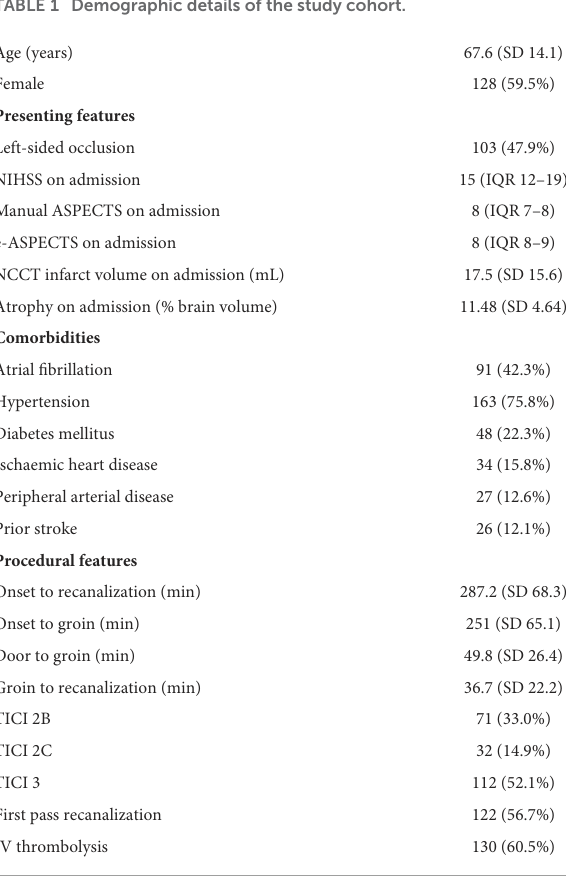
TABLE 1 Demographic details of the study cohort. TABLE 2 Univariate and multivariate predictors of mRS 0–2 at 90